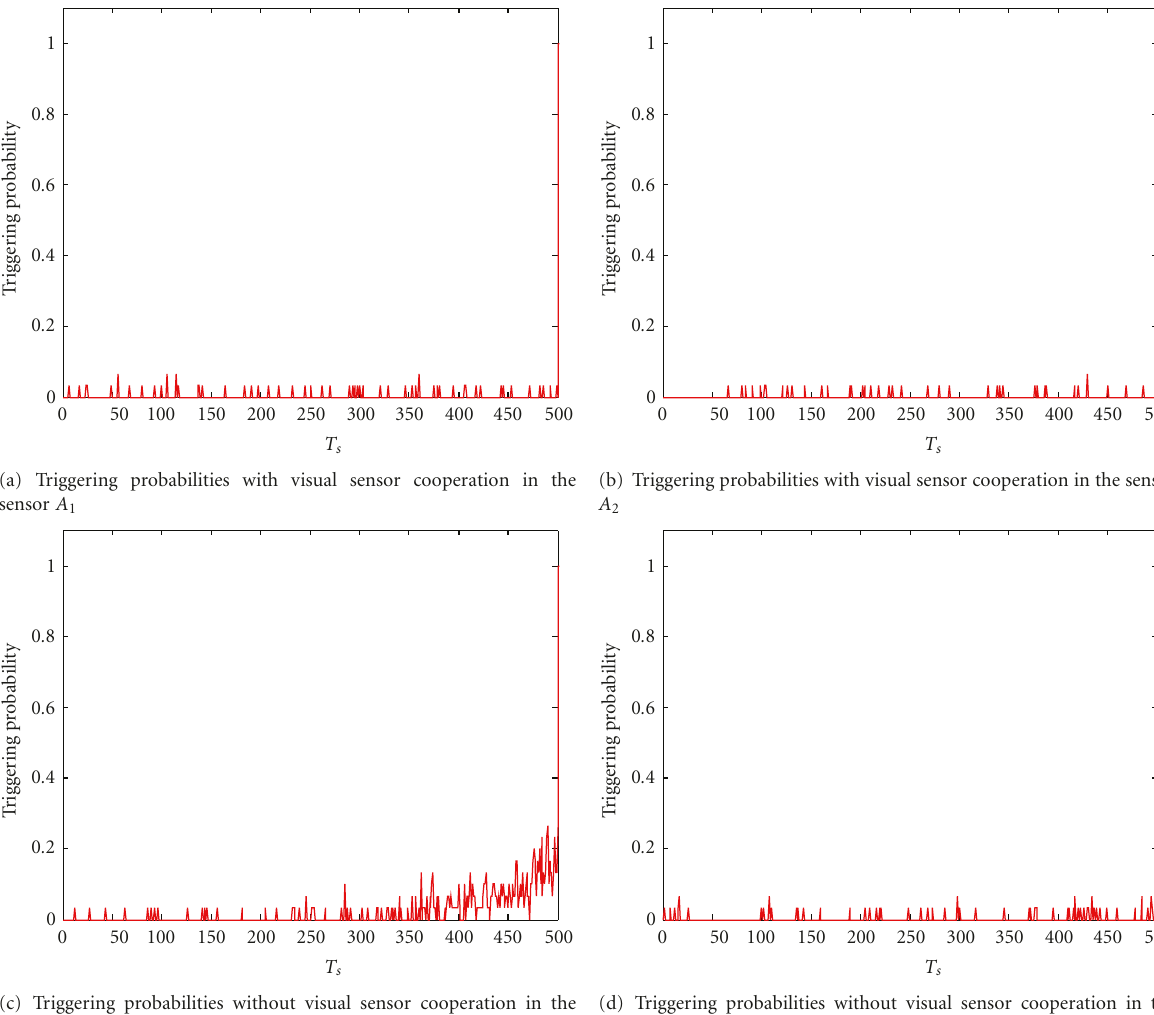
(d) Triggering probabilities without visual sensor cooperation in the sensor A 2 Figure 19: Triggering probabilities of the two sensors between 1 T s and 500 T s